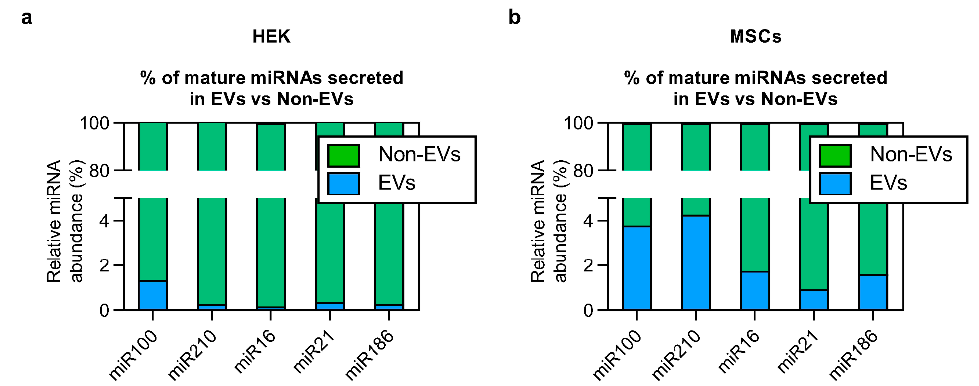
Figure 5. RT-qPCR quantification of mature miRNAs from EV and Non-EV fractions at their basal cellular expression level. Regardless of relative miRNA enrichment levels, the majority of secreted miRNAs are found outside of EVs both in HEK ( a ), and MSC ( b ) samples and the Non-EV material contains a striking 96–99% of total secreted miRNAs.